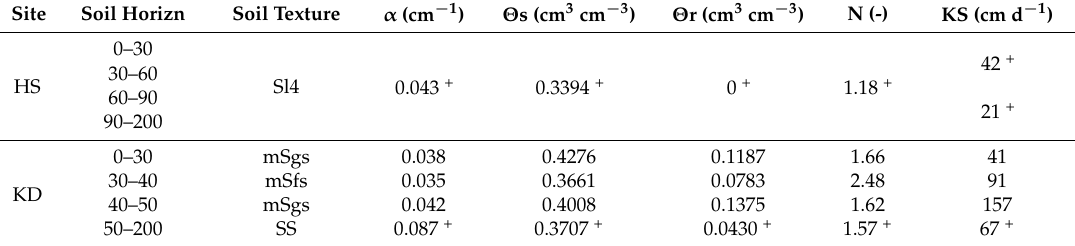
Table 3. Soil texture, van Genuchten parameter considering Mualem parameterization ( α , θ s, θ r, and n) and saturated water conductivity (KS) for Hohenschulen (HS) and Karkendamm (KD) subdivided in the different soil horizons [cm]. If not extra assigned, parameter values result from direct measurements at the soil pits dug at the two